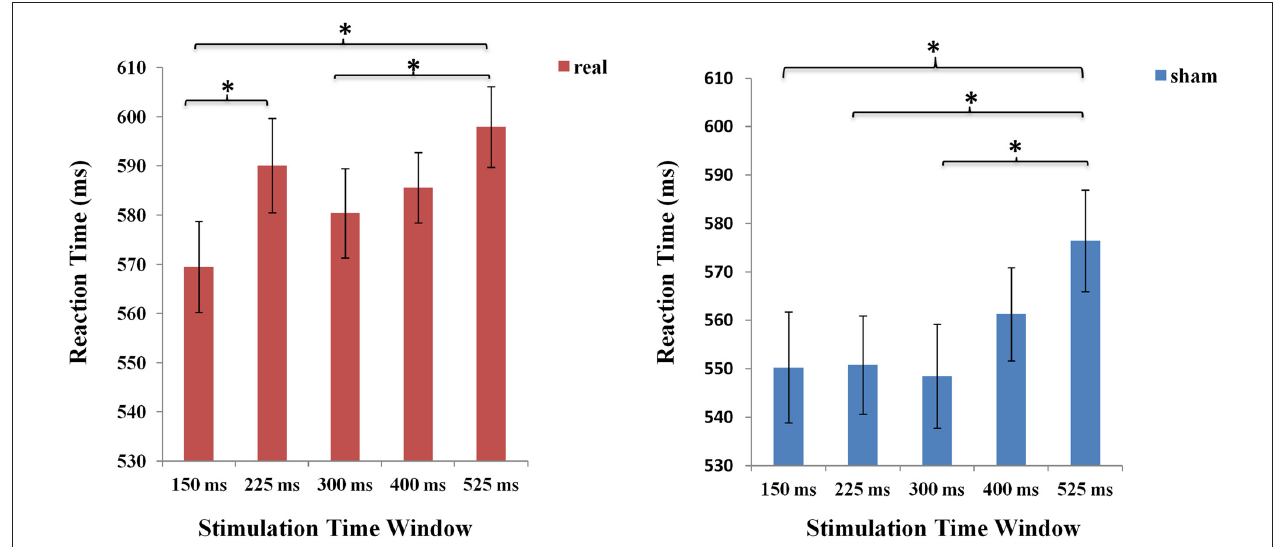
FIGURE 5 | The mean RTs of the five time windows in real and sham stimulation conditions respectively. An asterisk means p < 0.05 (Bonferroni corrected).